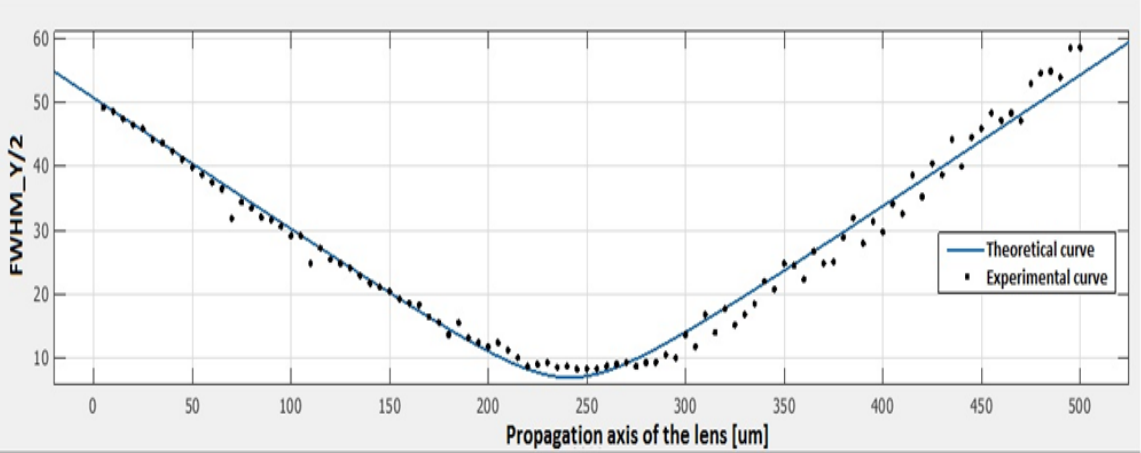
Figure 8. Measured intensity profile of the wave front of the off-axis holographic cylindrical lens (black dots) and fit with a theoretical curve (solid blue